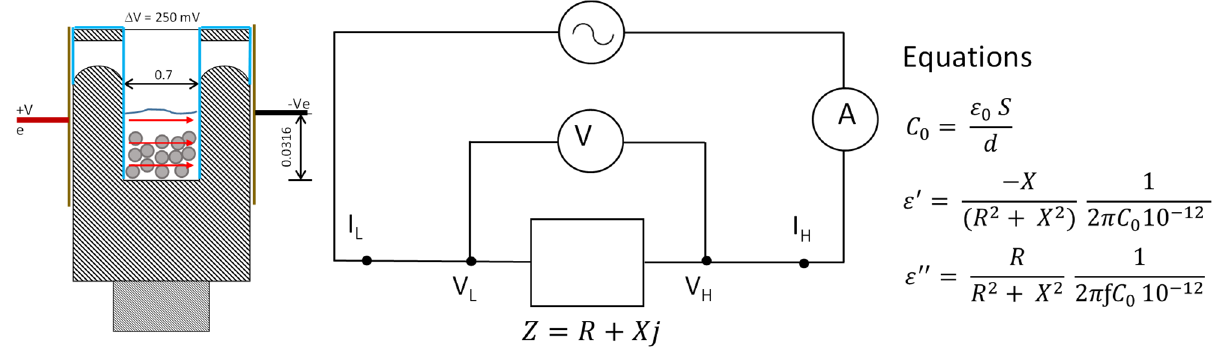
Figure 5. Detail of sensor of Impedance measurement in radiofrequency range, to determine the release of encapsulated active compound, the electric circuit of sensor and the equations to determine the permittivity.